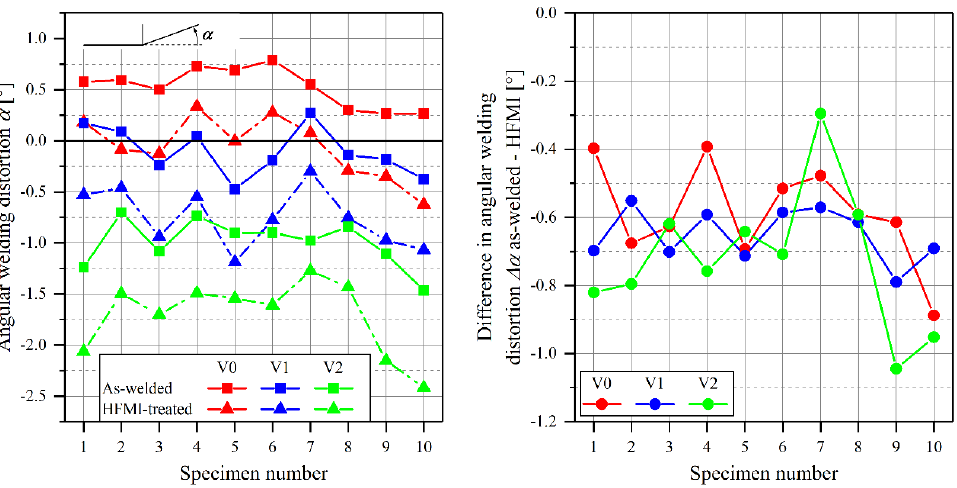
Figure 5. Effect of HFMI-treatment on angular distortion.